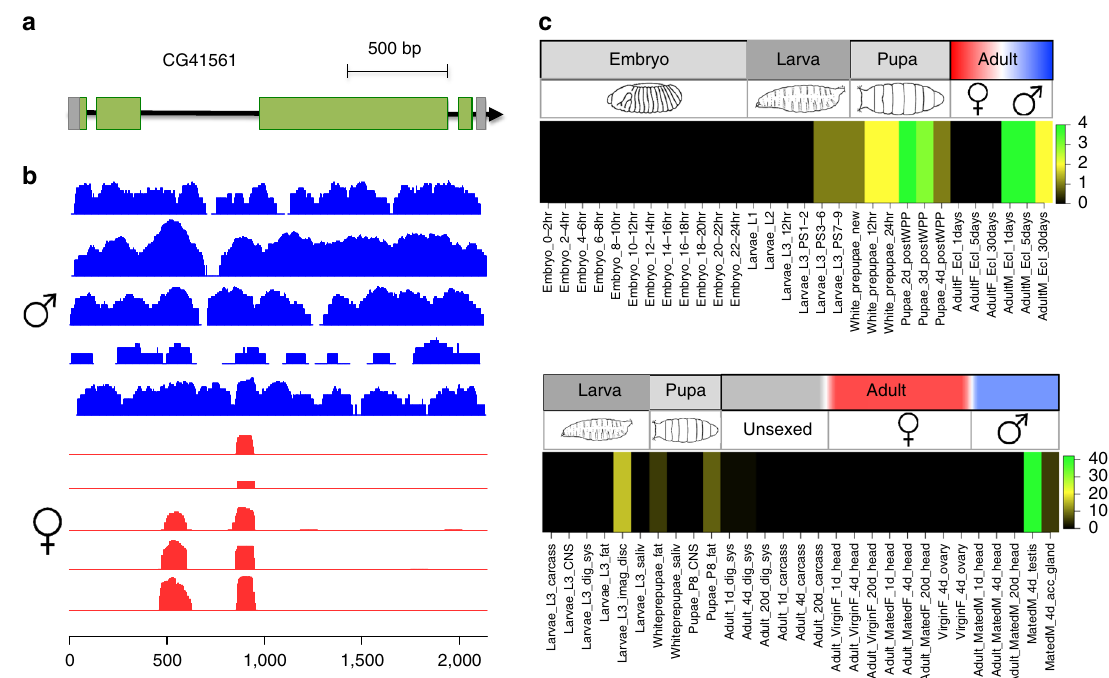
Fig. 2 CG41561 , a new protein-coding gene on the D. melanogaster Y chromosome. a Intron/exon structure of CG41561 ( grey are non-coding exons, green are coding exons). b Mapping of fi ve male ( blue ) and fi ve female ( red ) Drosophila genomic reads to CG41561 (for strain information see Supplementary Table 2). c Expression pro fi le of CG41561 across developmental stages ( top ; samples are ordered by developmental time) and larval and adult tissues ( bottom ); colors in heatmap refer to expression level. CG41561 is fi rst expressed in third instar larvae, and shows maximum expression in pupae and young adult males (it is not expressed in females). Across tissues, CG41561 is expressed in imaginal discs of third instar larvae and most highly in adult male testis. Expression pro fi les are taken from fl ybase. CNS, central nervous system; dig_sys, digestive system; fat, fat body; imag_disc, imaginal disc; saliv, salivary gland; acc_gland, accessory gland; 1d, 1-day; 4d, 4 days; 20d, 20